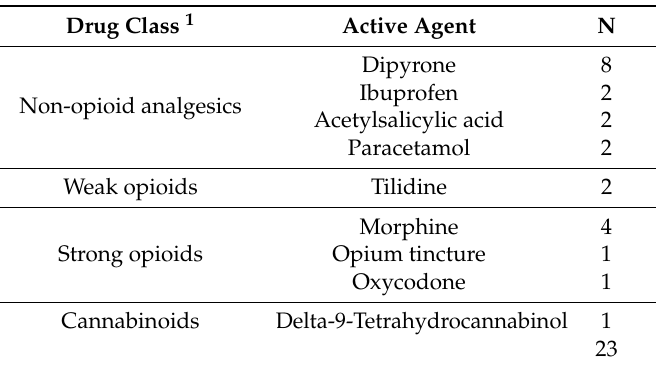
Table 1. Listing of received